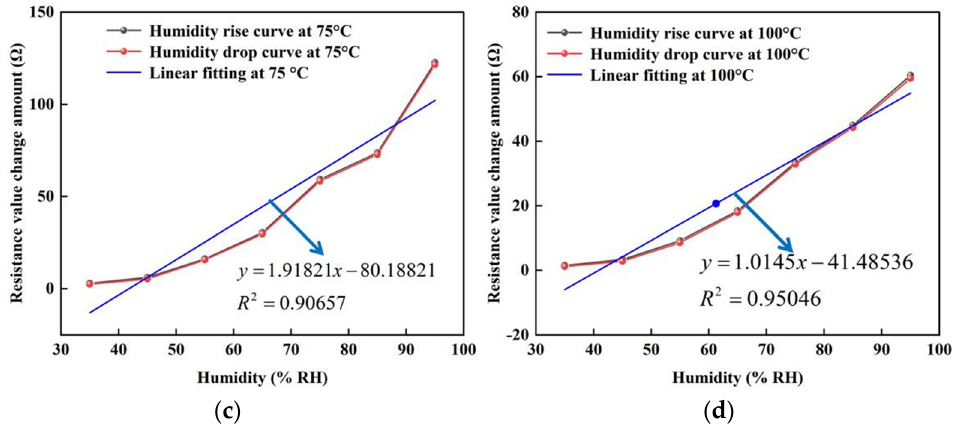
Figure 12. The resistance change curve of the humidity sensor at different temperatures. ( a ) At room temperature. ( b ) At 50 °C. ( c ) At 75 °C. ( d ) At 100 °C.